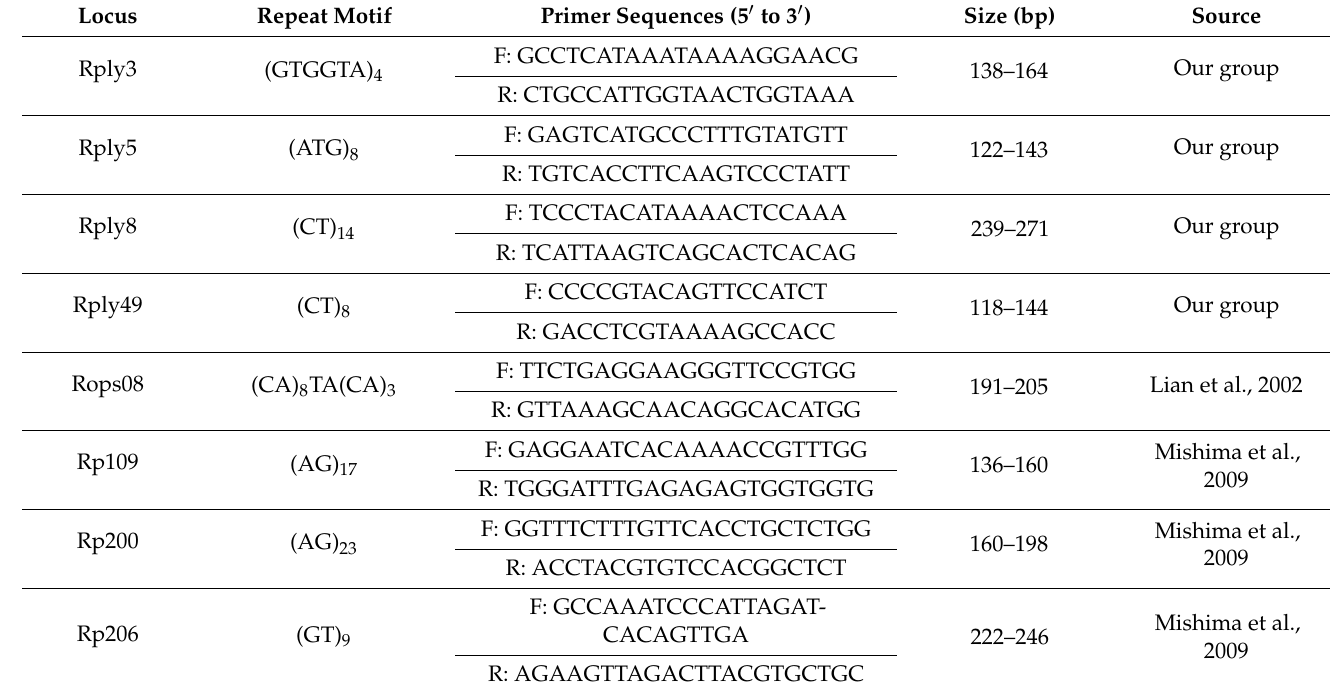
Table 2. Information of four EST-SSR and four genomic-SSR